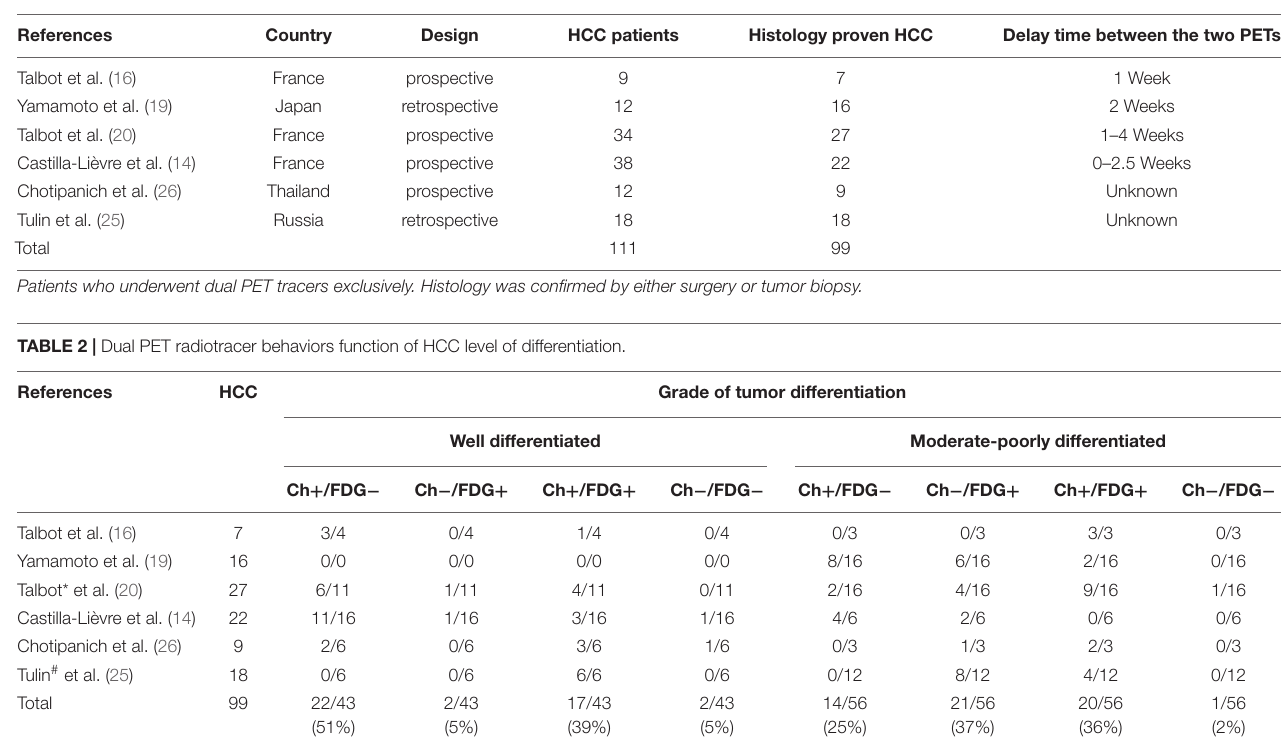
TABLE 1 | Characteristics of the included studies with dual PET tracer.